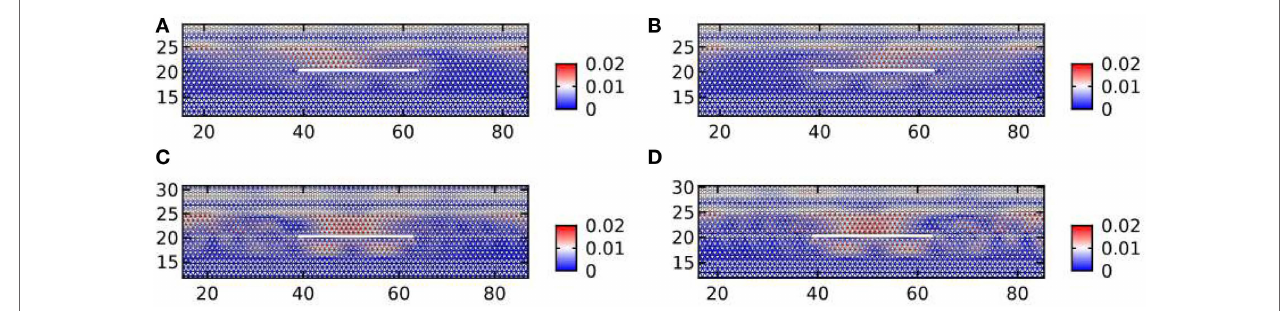
FIGURE 9 | The harmonic responses to a shear plane wave of frequency ω = π rad/s corresponding to the Dirac point for the triangular lattice with resonators. In panels (A,B) , we substitute the cluster of Figure 8B , which is finite in the horizontal direction, with an infinite strip. In panels (A,B) , the tilting is clockwise and anticlockwise, respectively. The structure in panels (C,D) is obtained from panel (A) by removing a horizontal line of resonators along the extension of the crack. In panel (C) , a homogeneous tilting is used; in panel (D) , the resonators above the line are rotated anticlockwise and those below clockwise.